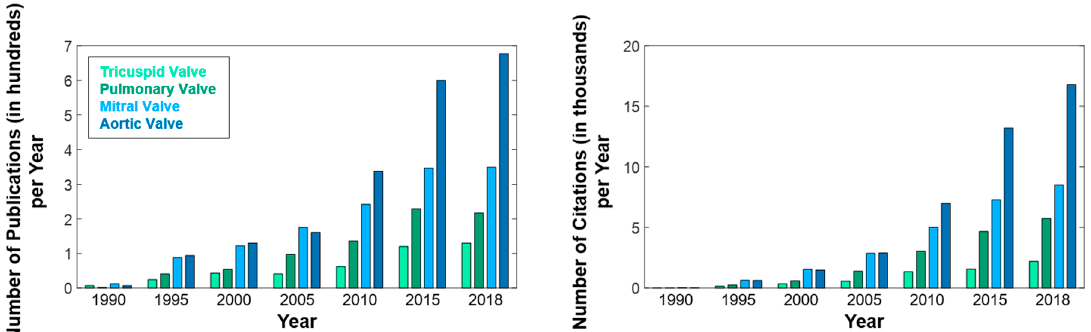
Figure 1. The number of publications ( left ) and the number of total citations ( right ) since 1990 for the four heart valves. Data was adopted from the Web of Science.